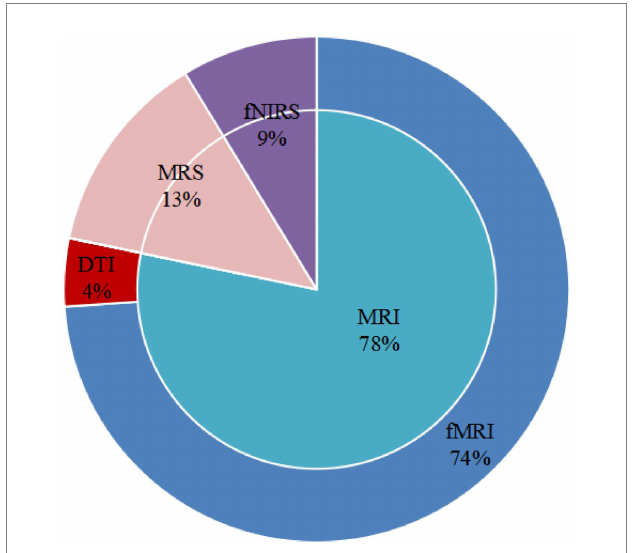
FIGURE 2 The proportion of scanning